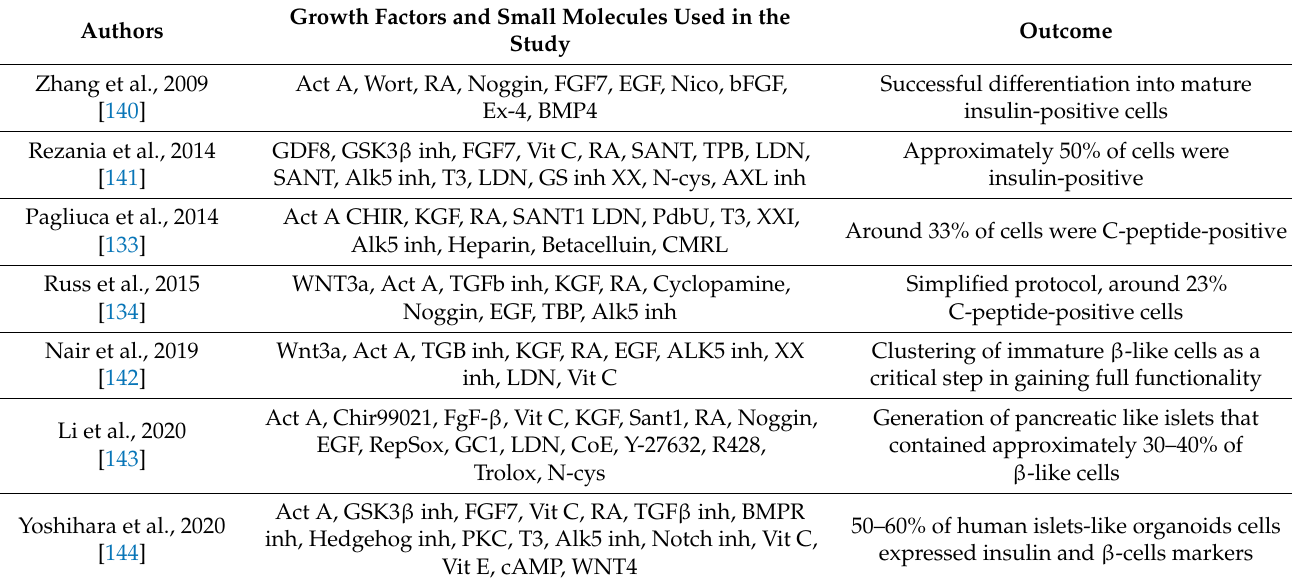
Table 1. List of available protocols for stem cell differentiation into β